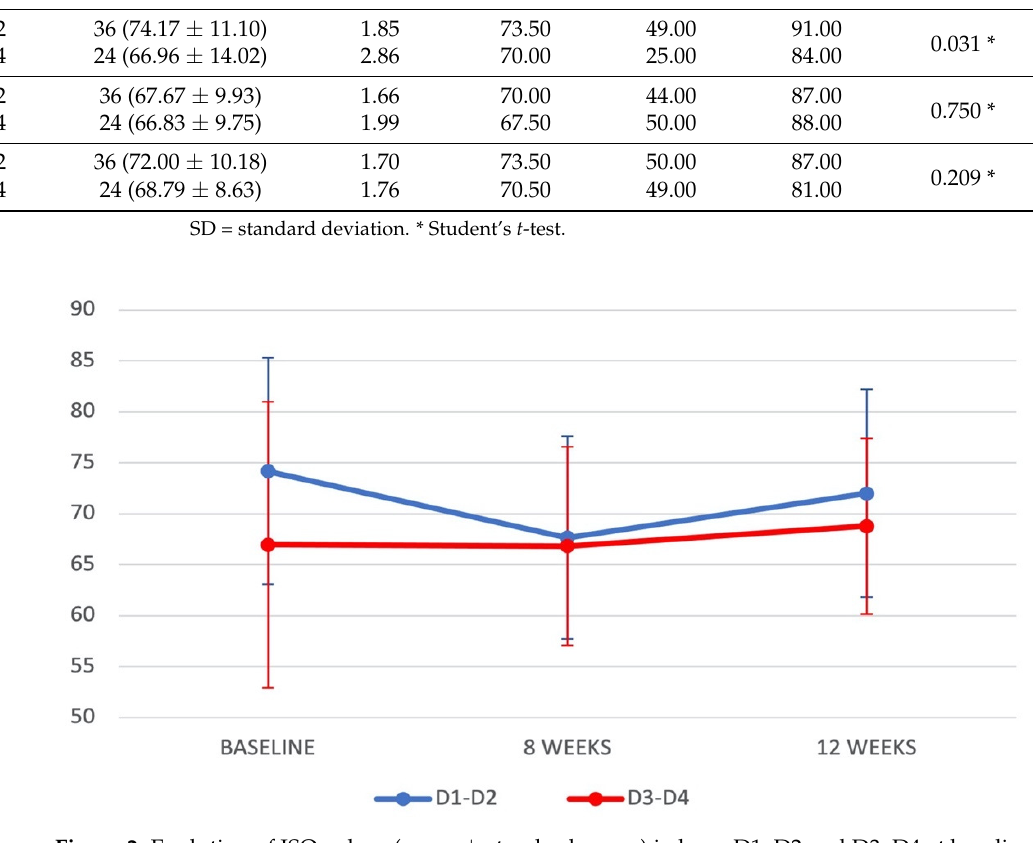
Figure 2. Evolution of ISQ values (mean ± standard errors) in bone D1–D2 and D3–D4 at baseline, after 8 weeks, and after 12 weeks.